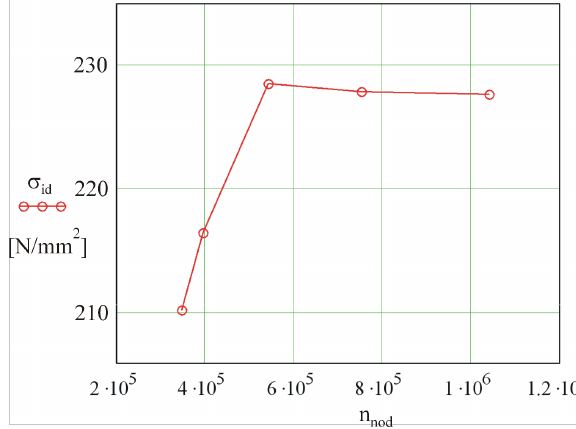
Figure 21: Convergence curve to check the stress σ id in the area where the three edges of the pole piece intersect (see Figure 19, fillet radius R=1 mm). Table 5: Order of Magnitude in the Engine Room.